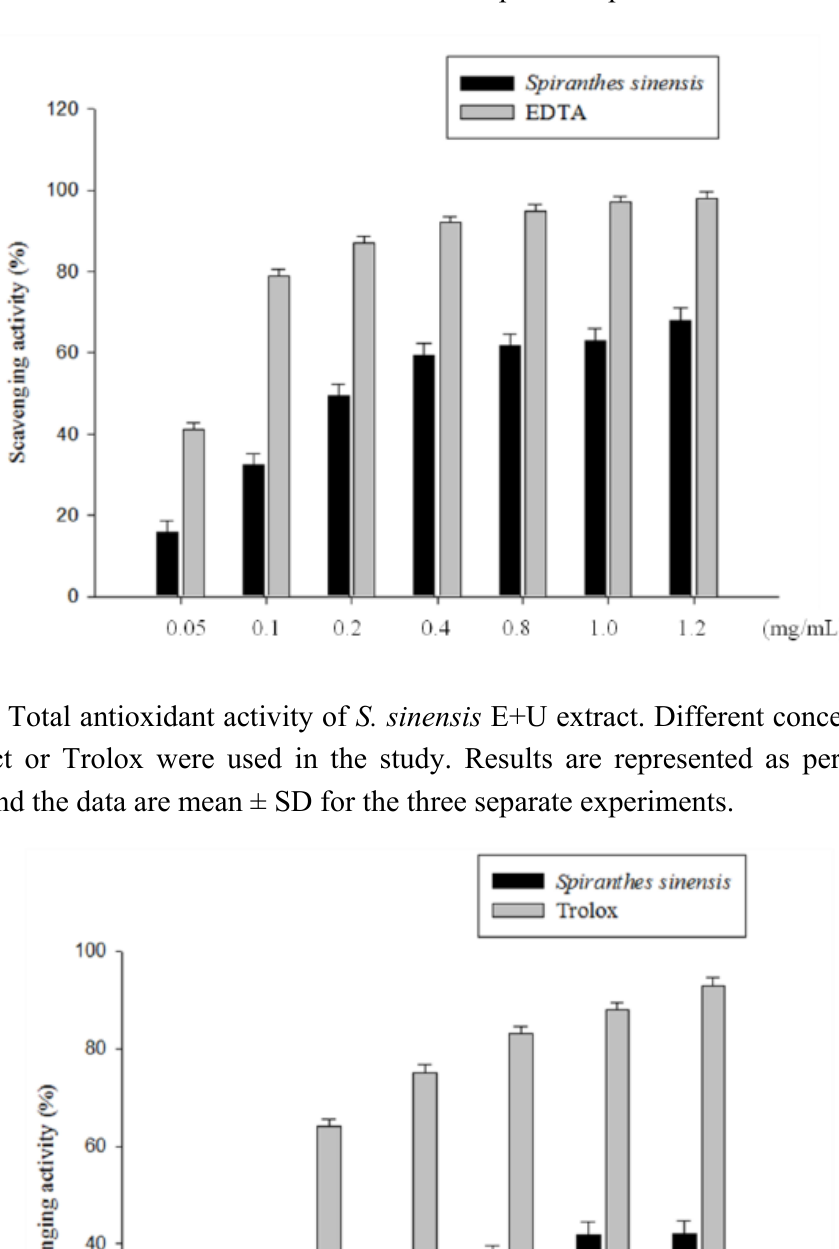
Figure 3. Metal-ion chelating activity of S. sinensis E+U extract. Various concentrations of the extract or EDTA were used in the study. Results are represented as percentages of control, and the data are mean ± SD for the three separate experiments.